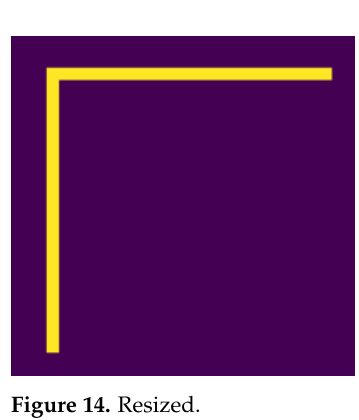
Figure 13. Rotated.